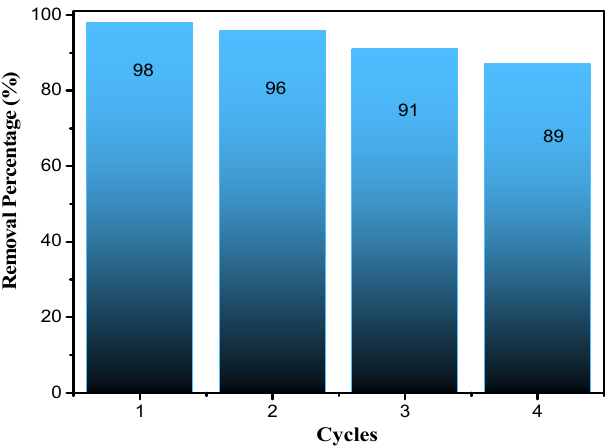
Figure 10. Variation of removal percentage of Cu (II) using MgY 2 O 4 @g-C 3 N 4 nanomaterials.